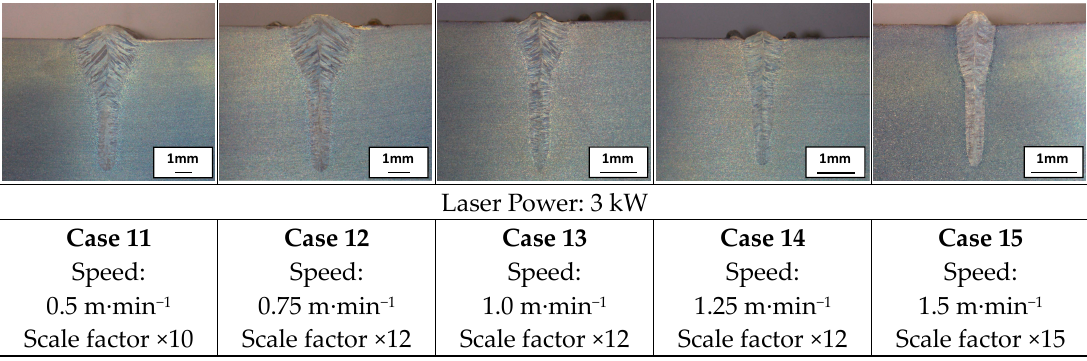
Figure 5. Bead geometry on BOP welding test (laser power: 3 kW, Case 11~15).